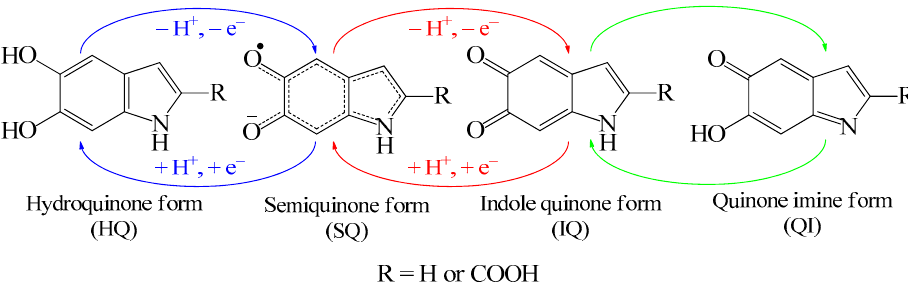
Figure 1. Scheme of the different redox forms of melanin building blocks in increased oxidation state. R = H for DHI species and R = COOH for DHICA species. Indolequinone imine and quinone imine forms are tautomers.